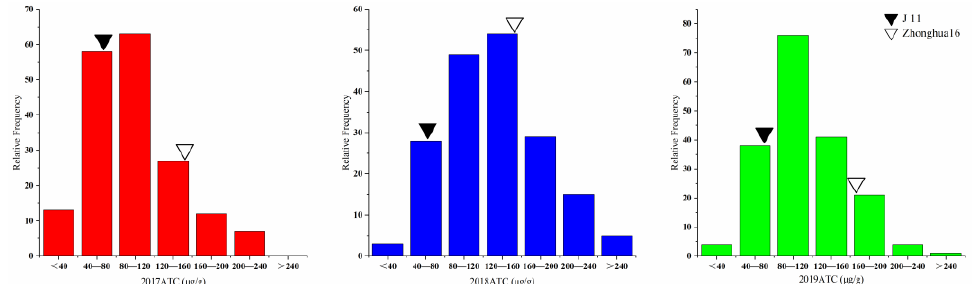
Figure 1. Phenotypic distribution of ATC in the RIL population with their parents in 3 years. Table 2. Analysis of variance for the ATC in the RIL population across three environments. Source df Mean Square F -Value